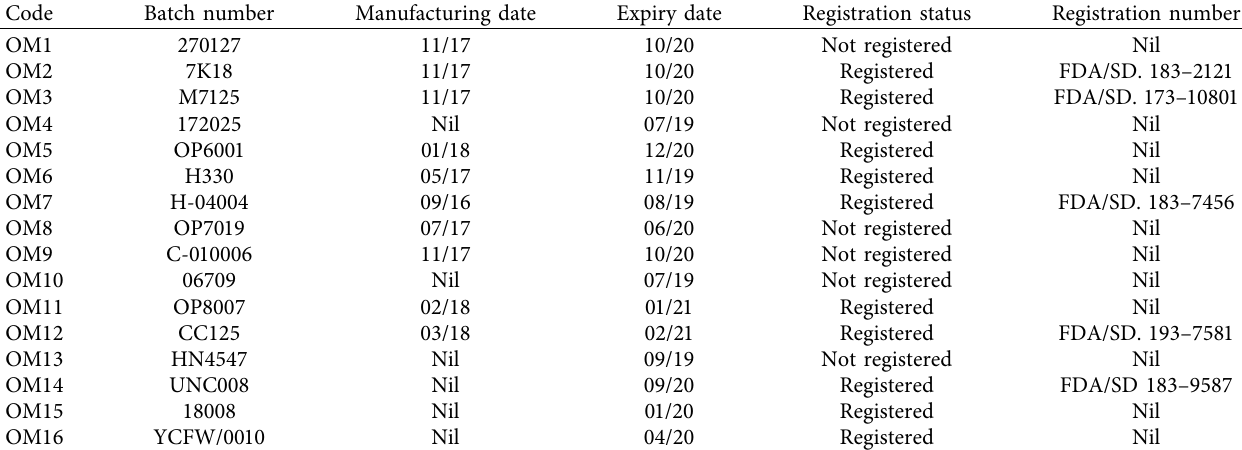
Table 1: Product information details.